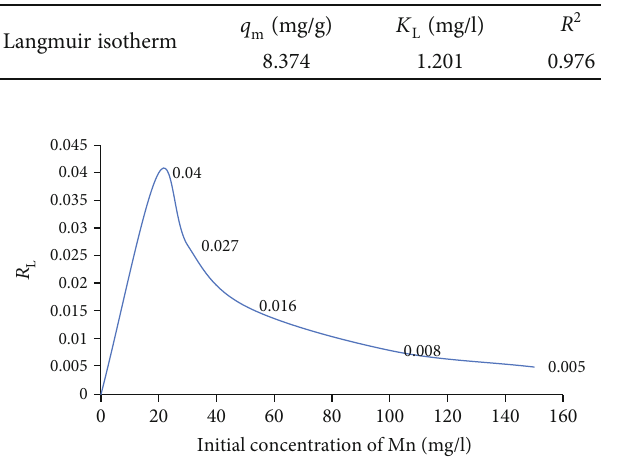
Figure 11: Langmuir isotherm for adsorption of Mn(II) ion on MnO-coated HPM surface.